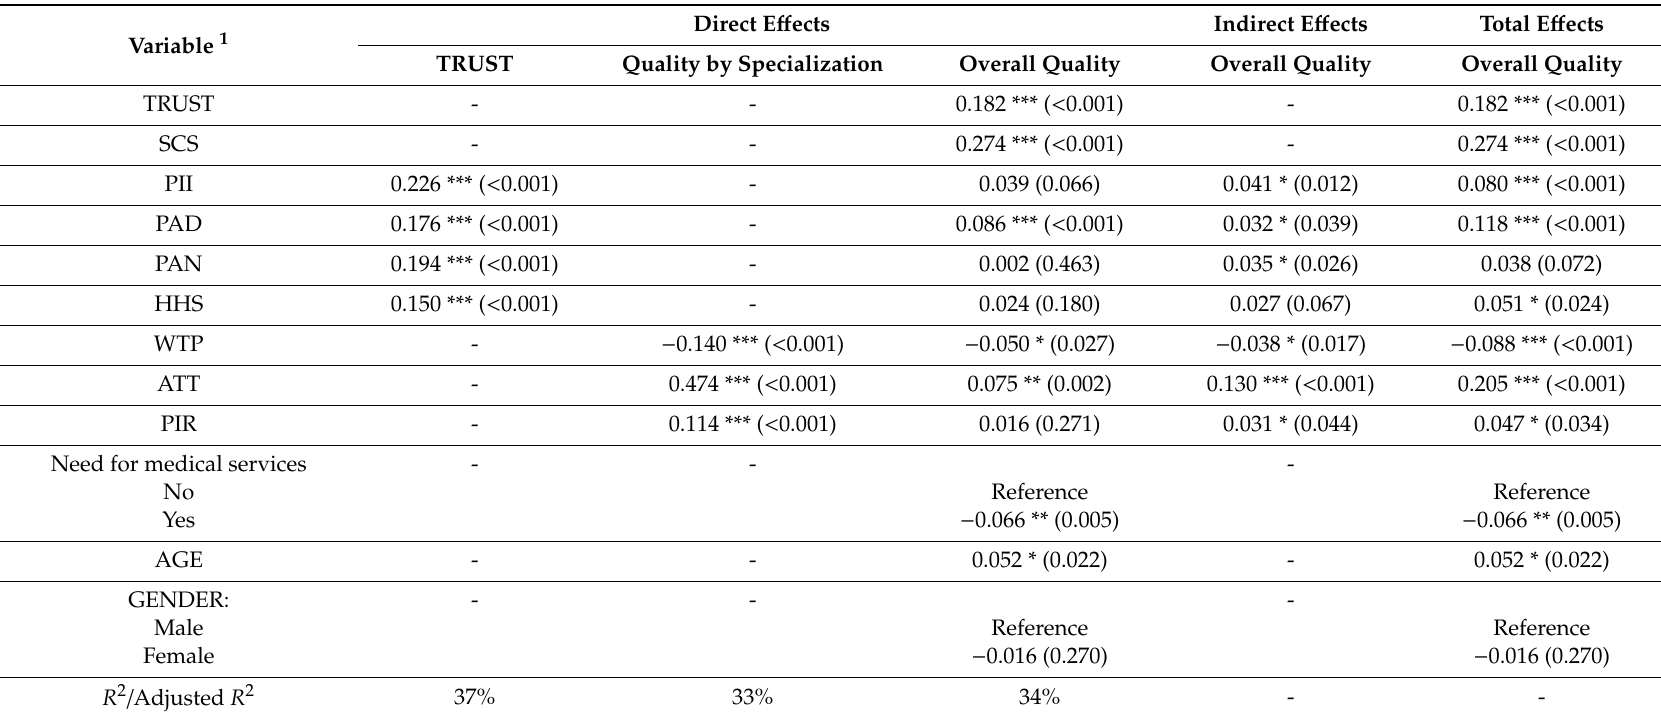
Table 5. The coe ffi cients of the structural